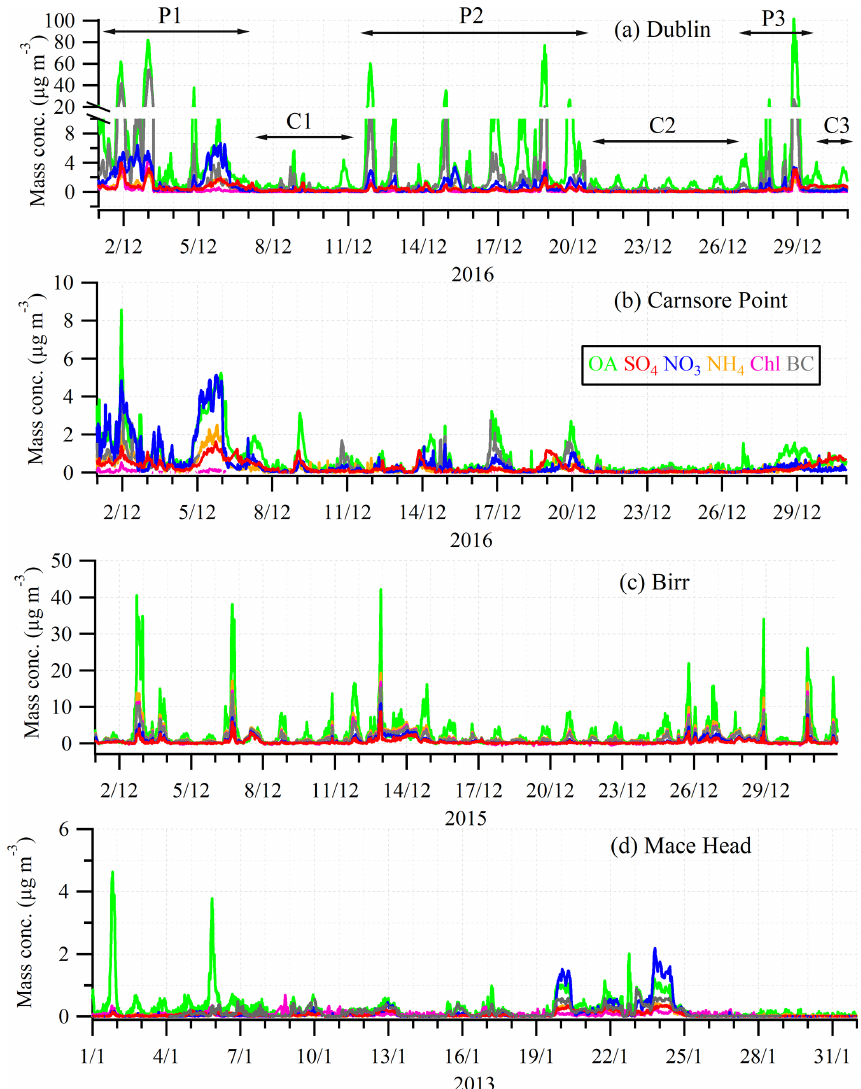
Figure 1. Time series of organic aerosol (OA), sulfate (SO 4 ), nitrate (NO 3 ), ammonium (NH 4 ), chloride (Chl), and black carbon (BC) at the urban background site in Dublin (a) , the rural site at Carnsore Point (b) , the midland town site in Birr (c) , and the coastal site at Mace Head (d) . The measurements at the Dublin site and Carnsore Point were conducted simultaneously in December 2016. The campaign in Birr was carried out in December 2015, and Mace Head was carried out in January 2013. BC, measured by AE-33 with 1min resolution or by MAAP with 5min resolution, was averaged to 30min to match the time stamp of the ACSM. Pollution periods (P1–P3) and clean periods (C1–C3) in Dublin are marked – see text for further